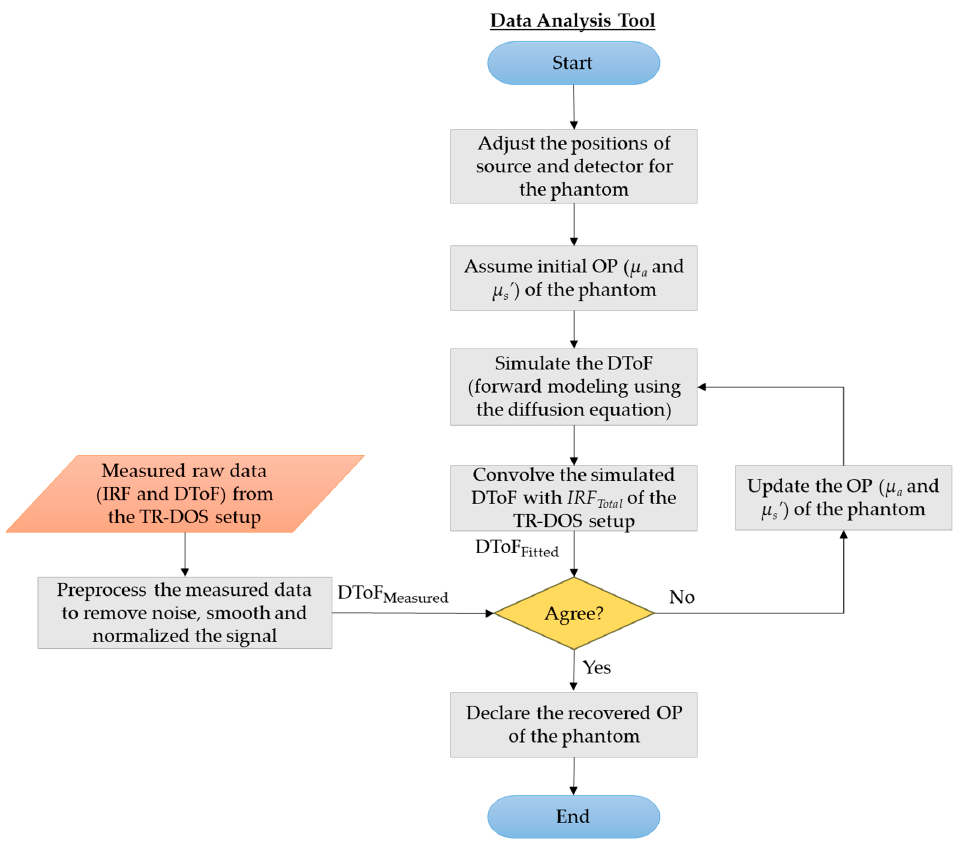
Figure 3. Flowchart of the data analysis process to recover the OP of the phantoms using the TR-DOS prototype.